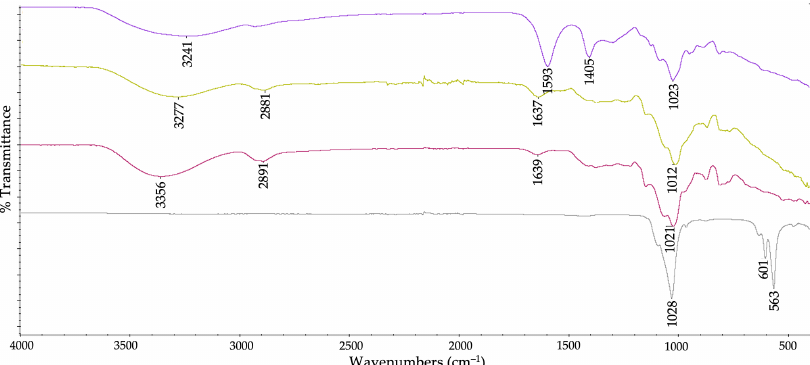
Figure A5. ATR – FTIR spectra of the biopolymers and HA .